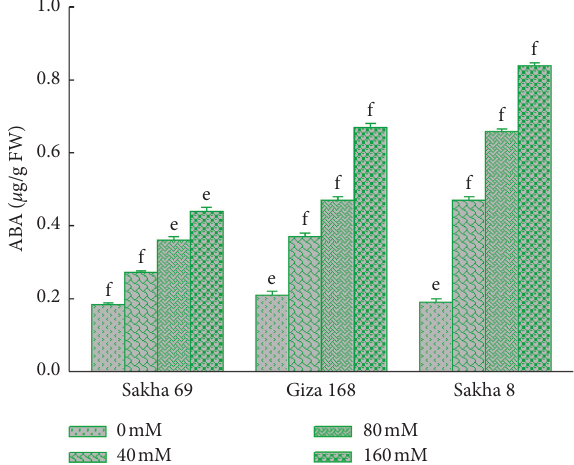
Figure 4: Response of ABA ( μ g/g FW) of wheat cultivars flag leaves to salinity stress at 2WASA. Each column symbolizes mean ± SE ( n � 3). The mean standard errors are demonstrated by error bars. Letters point out significant differences ( p < 0 .